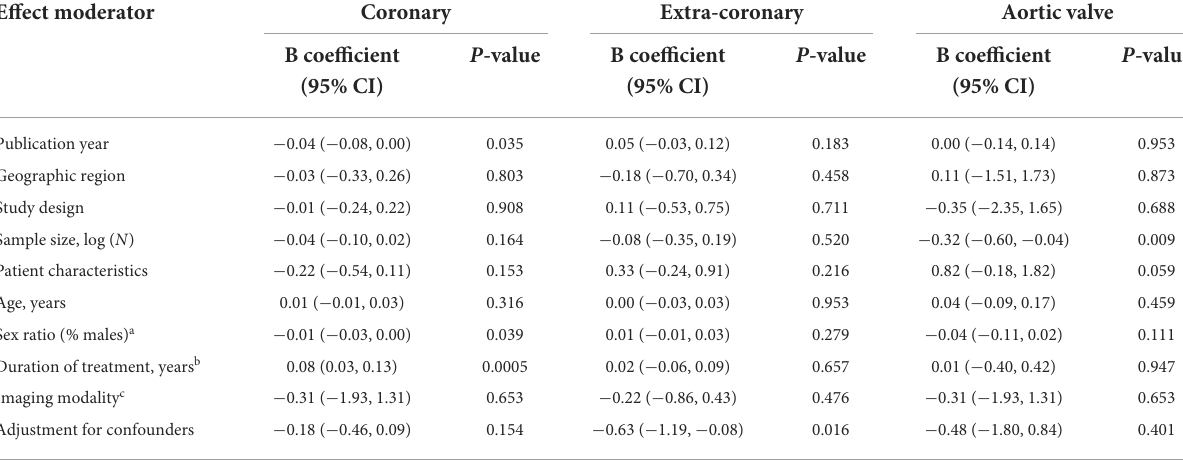
TABLE 2 Meta-regression analysis of potential effect